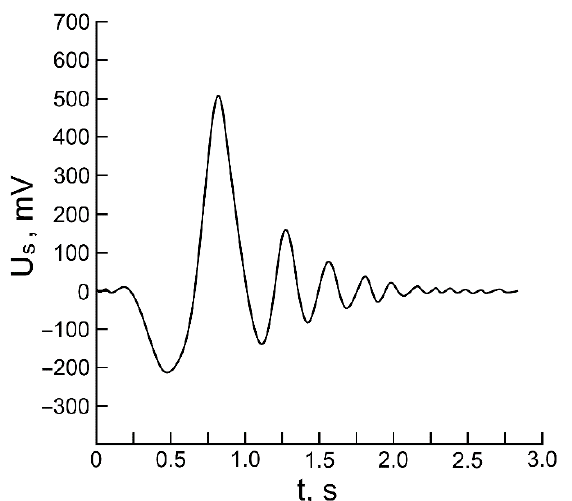
Figure 7. The dependence of the change in the amplitude U s of the registered NMR signal on time t at T = 298.4 K.